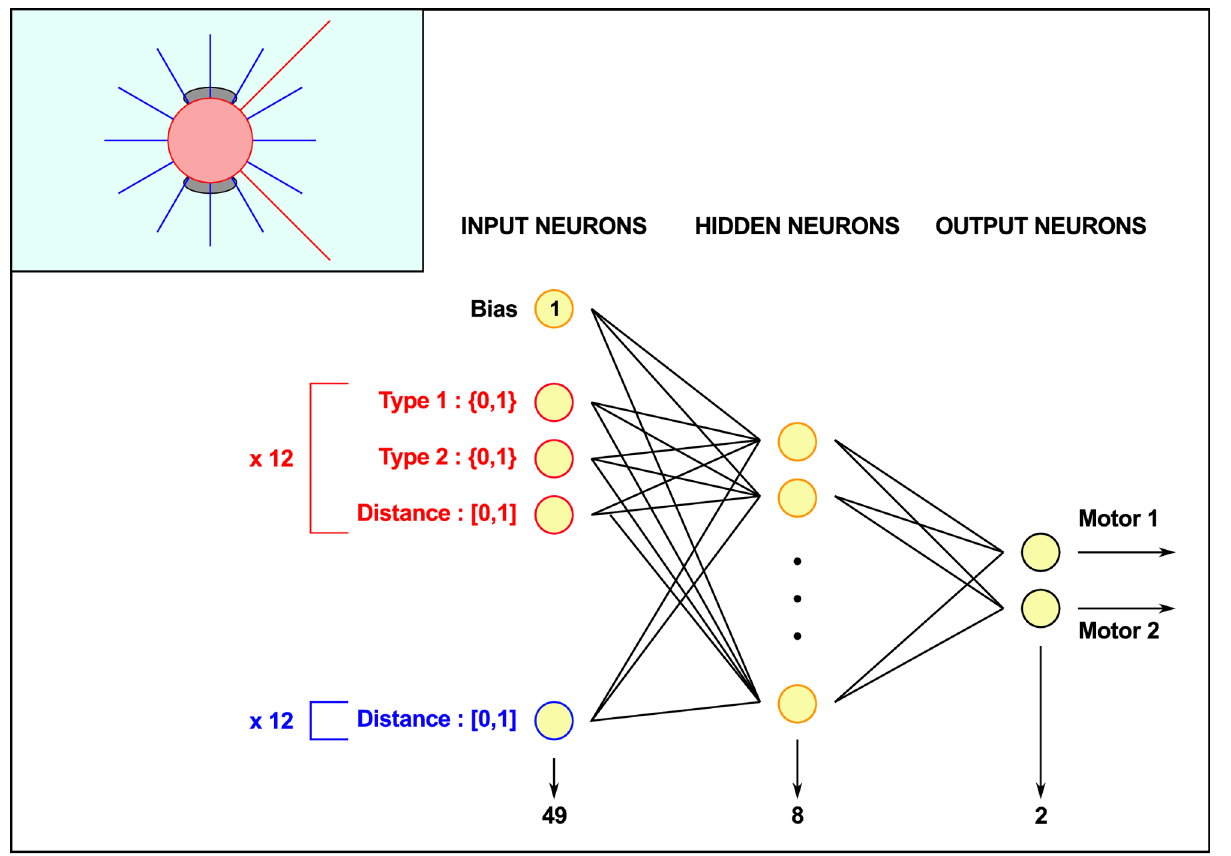
Fig 2. Diagram of the simulated robotic agent used in the simulation (inset) and its neural network controller. The blue lines represent the 12 proximity sensors and the red lines represent the front camera. Inputs “ Type 1 ” and “ Type 2 ” are two boolean values used to represent the type of the agent (encoded with two bits) recognized by the camera